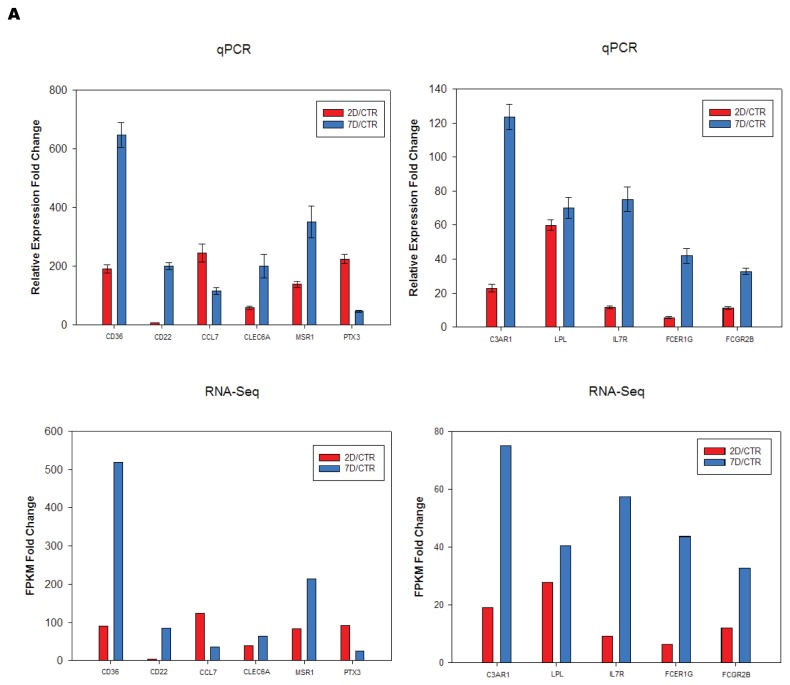
Validation using qRT-PCR.Relative expression fold change from qRT-PCR were calculated using 2-ΔΔCt method. Error bars represent ±SD (n=3). FPKM fold change were the ratio of average FPKM between samples.